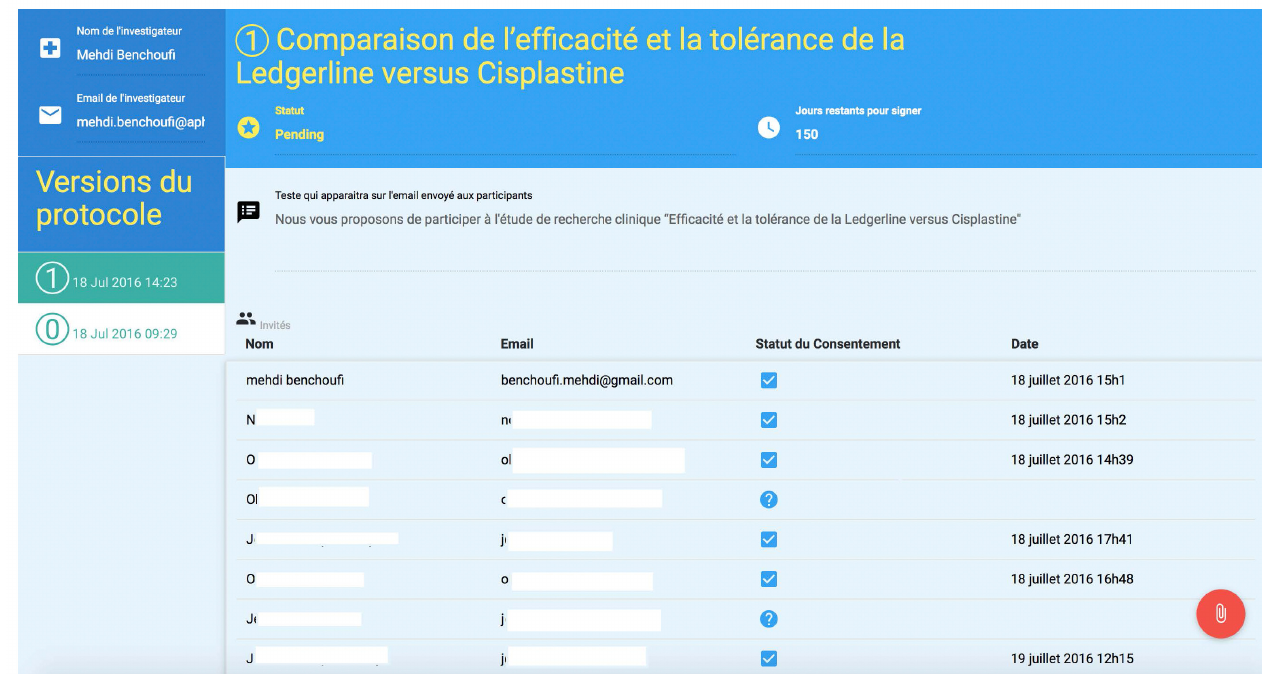
Figure 3. Investigator dashboard for Blockchain consent collection